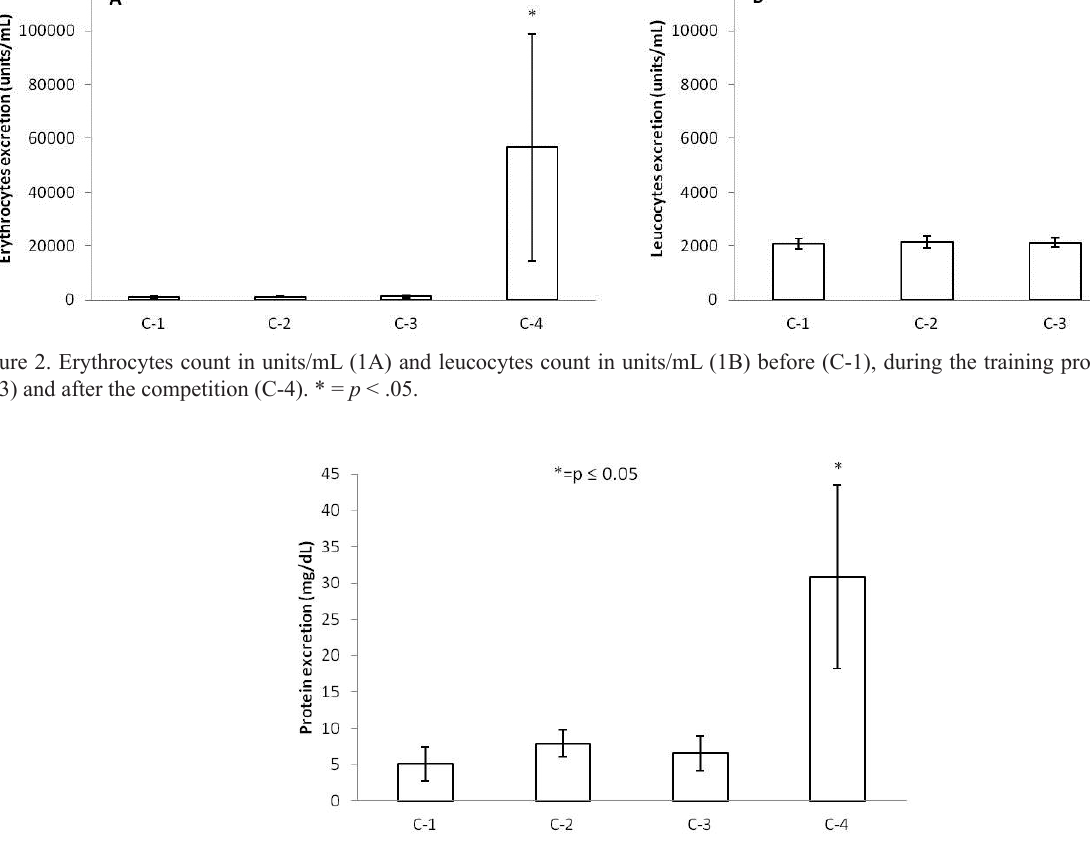
Figure 3. Protein excretion in mg/dL before (C-1), during the training program (C-2), before (C-3) and after the competition (C-4). * = p <